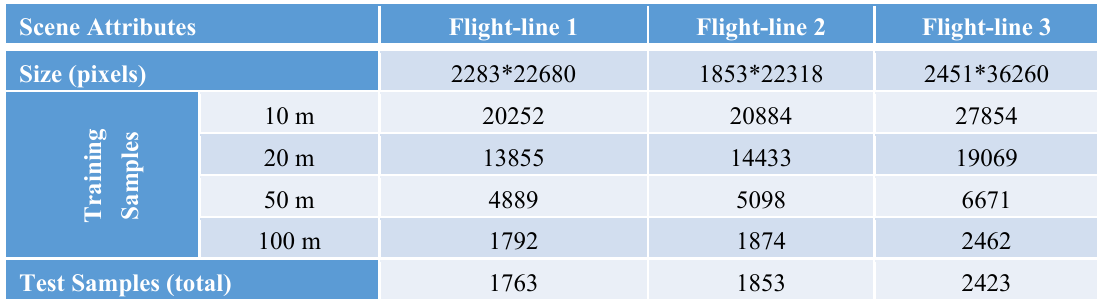
Table 1. Training and test sample sizes of the evaluated flight-lines for different sampling